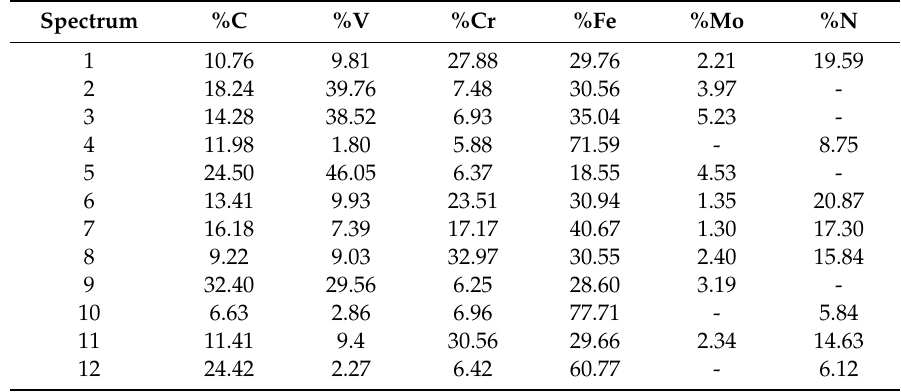
Figure 4. Phases of the nitrided layer, analyzed by energy dispersive X-ray (EDX) microanalysis; ( a ) Experiment 5; ( b ) Experiment 6; ( c ) Experiment 7; ( d ) Experiment 8. Table 6. Semi-quantitative analysis of the phases listed in Figure 4 by means of energy dispersive X-ray (EDX) microanalysis. (% in